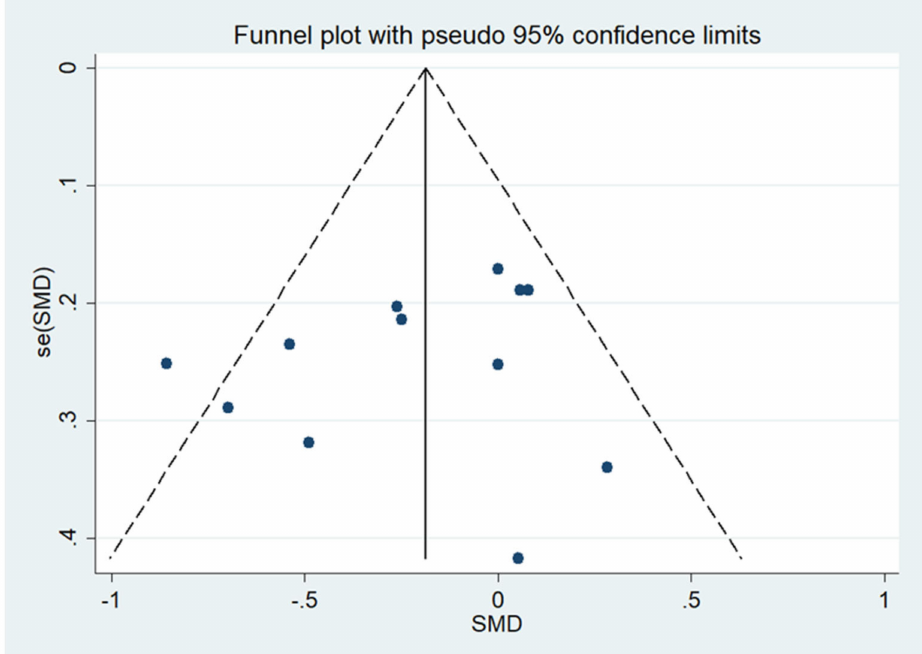
Figure 5. The funnel plot of the publication bias of body